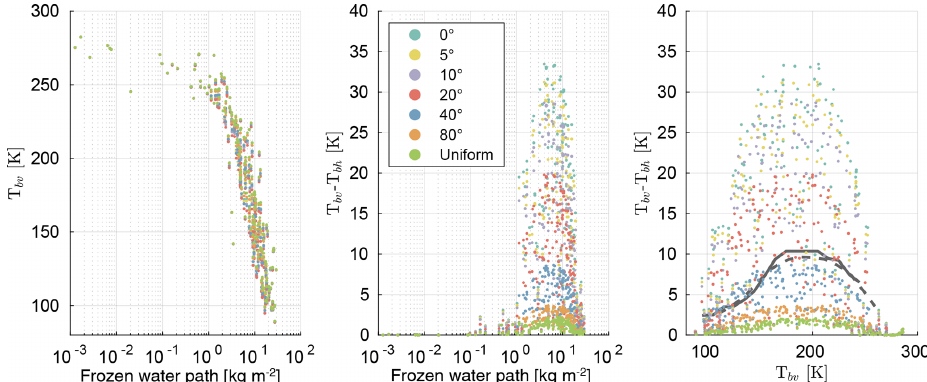
Figure 15. Same as Fig. 12 but with plate type 1 for snow instead of large plate